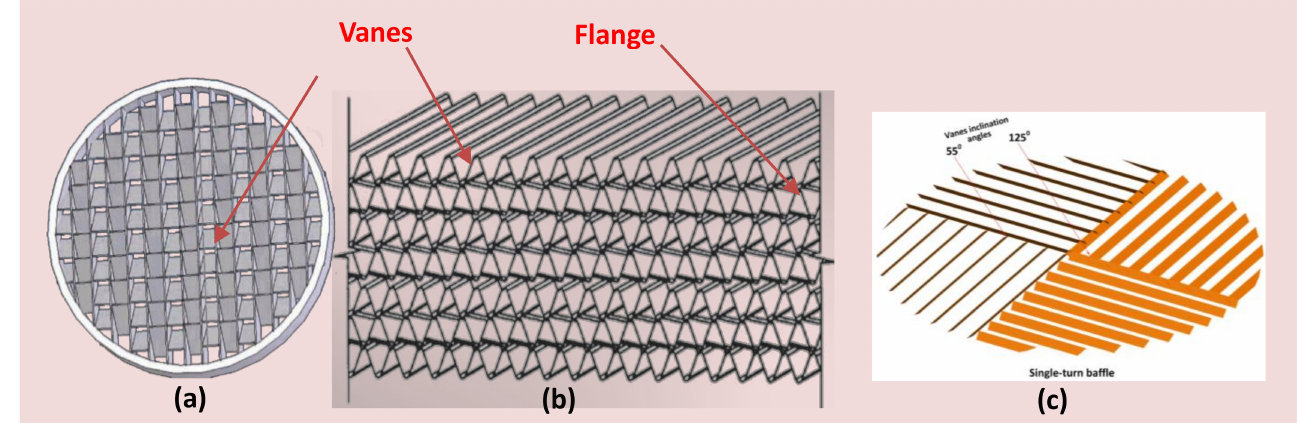
Figure 17. Baffle designs. ( a ) Crosser baffle; ( b ) KBR fixed packing baffle; ( c ) Single turn baffle. Adopted from Zhang